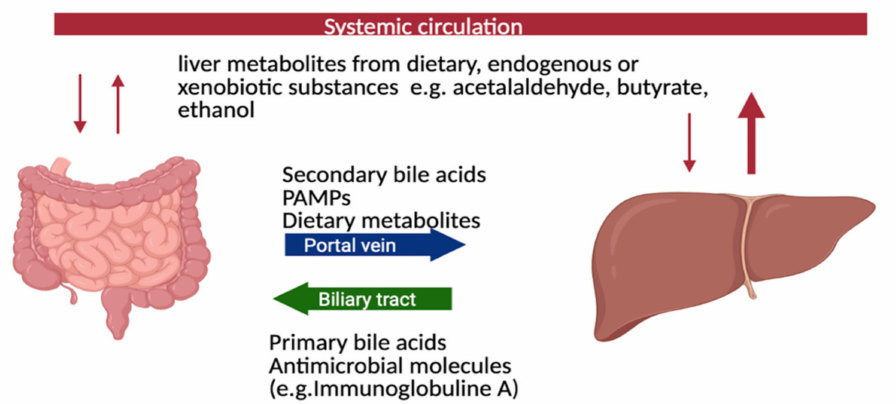
Figure 1. Bidirectional communication between gut and liver through the biliary tract, portal vein, and systemic circulation. The liver communicates with the intestine by transportation of bile salts and antimicrobial molecules (e.g., immunoglobulin A) to the intestinal lumen through the biliary tract, maintaining gut eubiosis by controlling unrestricted bacterial overgrowth. Additionally, endogenous and exogenous metabolites from the liver such as free fatty acids (FFA), ethanol or choline metabolites are transported to the intestine via the capillary system [32,33]. Pathogen-associated molecular patterns